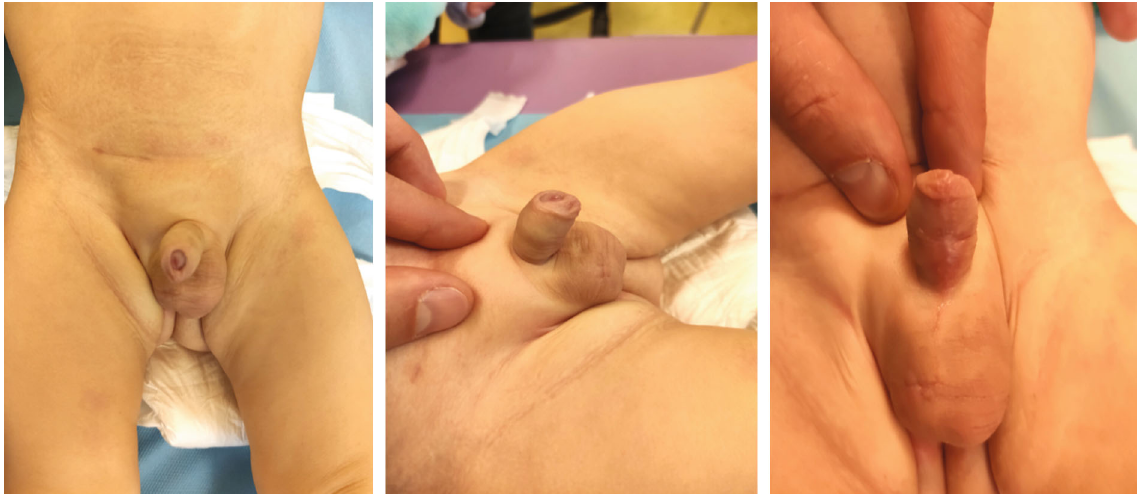
Figure 4: Postoperative results at 6 months: wound healing is complete without chordee and with a good esthetic outcome. The patient has normal voiding by urinary meatus without fi stula